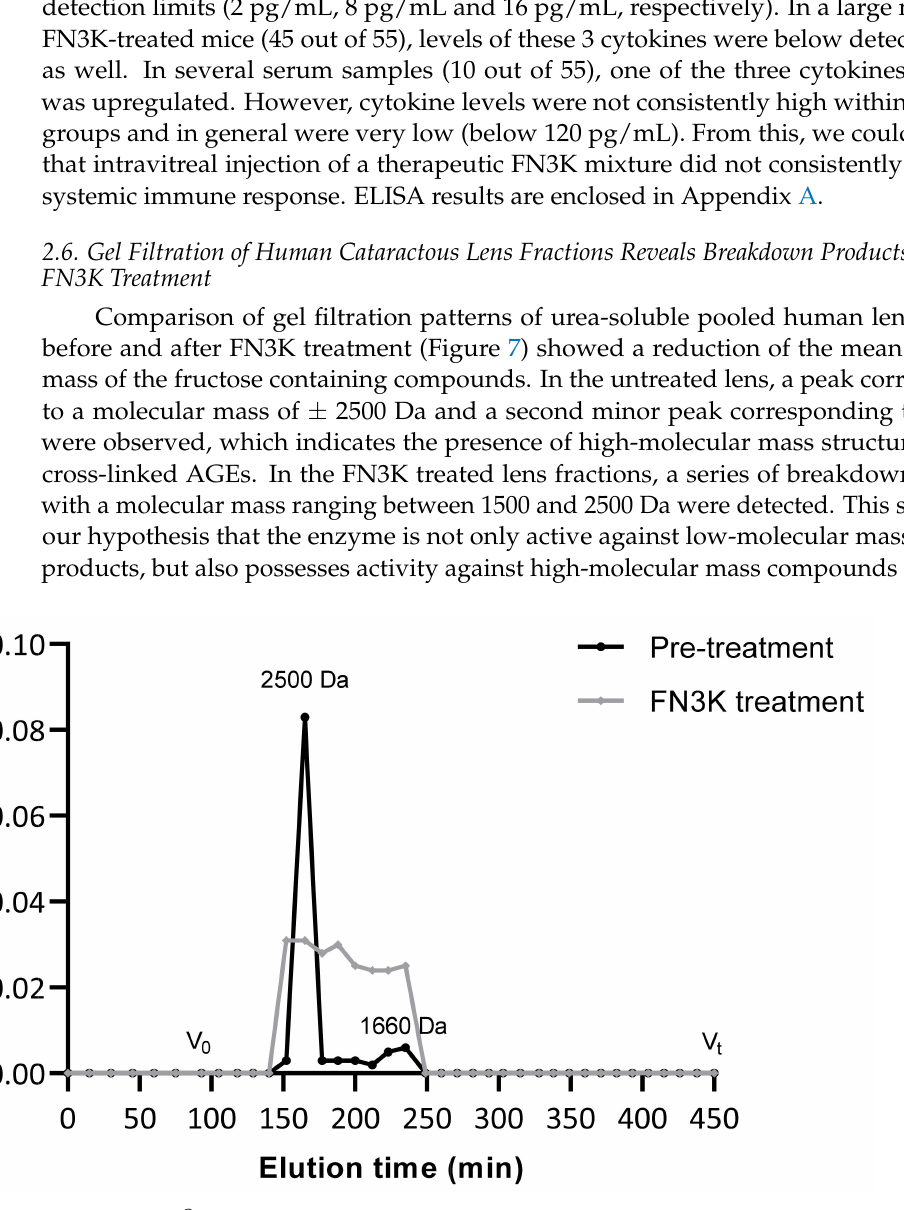
Figure 7. Gel filtration patterns (Sephadex ® G-25 Fine resin) of urea-soluble lens fractions before and after FN3K treatment showing the absorbance at 488 nm (Seliwanoff reaction) of high-molecular mass fructose containing compounds (AGEs) as a function of the elution time. V 0 (>5 kDa) indicates the void volume, Vt (<500 Da) the terminal